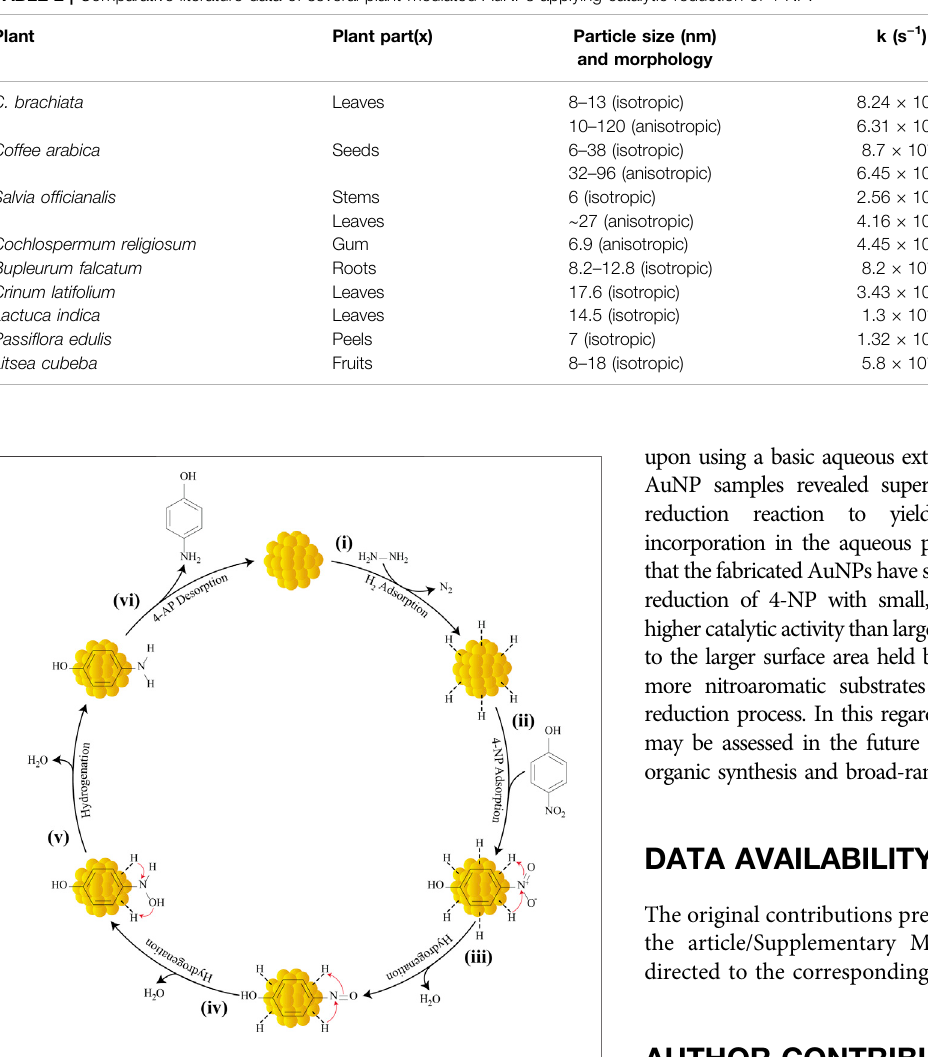
FIGURE 15 | Mechanism for the catalytic reduction of 4-NP to 4-AP by AuNPs using hydrazine hydrate as the reducing agent.